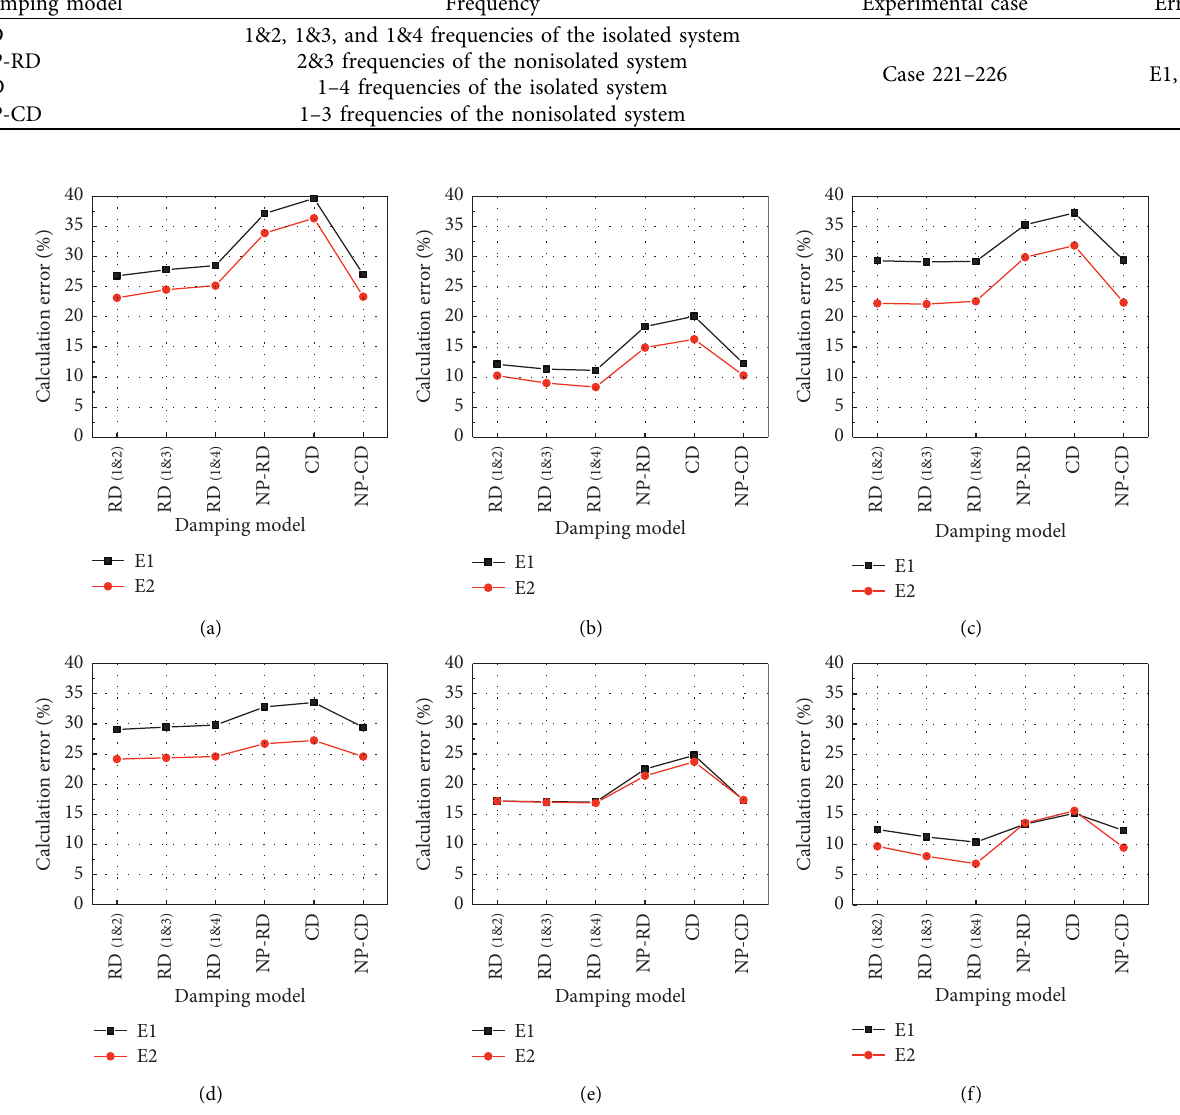
Figure 15: Calculation errors of the first story displacement by using different damping models (PGA � 0.2g): (a) case 221, (b) case 222, (c) case 223, (d) case 224, (e) case 225, and (f) case 226.